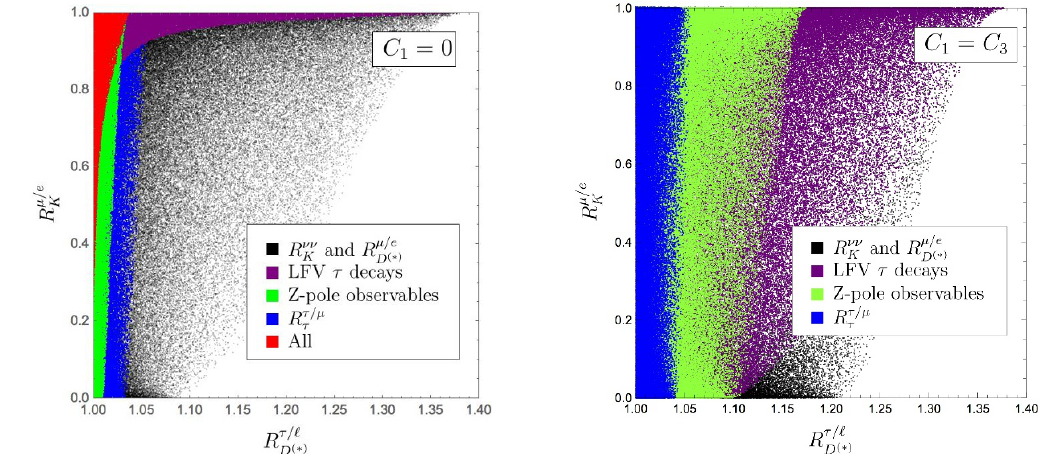
Figure 5 . Impact of one-loop-triggered constraints when addressing the B anomalies through left- handed currents, for two di(cid:11)erent C 1 vs. C 3 con(cid:12)gurations ( left : C 1 = 0, right : C 1 = C 3 ). For C 1 = C 3 , simultaneously imposing all bounds is actually equivalent to impose R (cid:28)=‘ (cid:28) alone. In the scan the parameters varied in the following ranges: C 1 ; 3 = (cid:3) 2 2 f(cid:0) 4 ; 4 g TeV (cid:0) 2 , (cid:3) 2 f 1 ; 10 g TeV, j (cid:21) d;e j 2 f 0 ; 0 : 5 g . All bounds refer to 2 (cid:27) uncertainties. 23